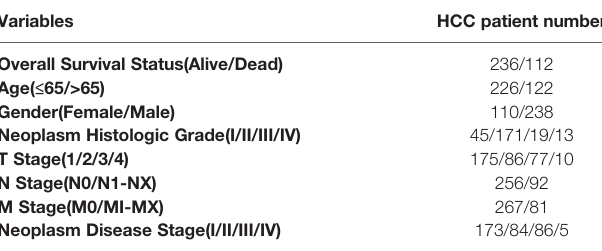
TABLE 1 | Basic characteristics of 348 HCC